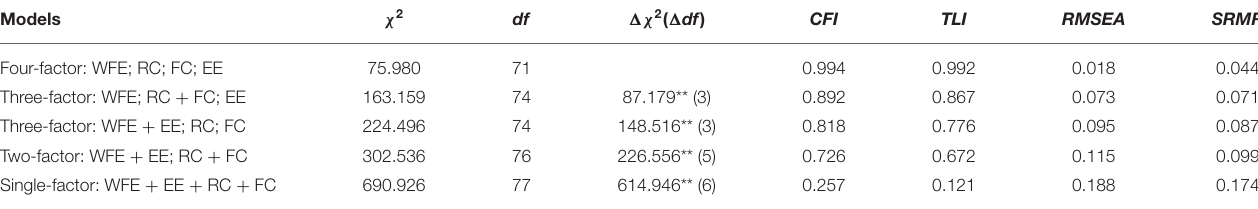
TABLE 2 | Model fit results for confirmatory factor analyses.